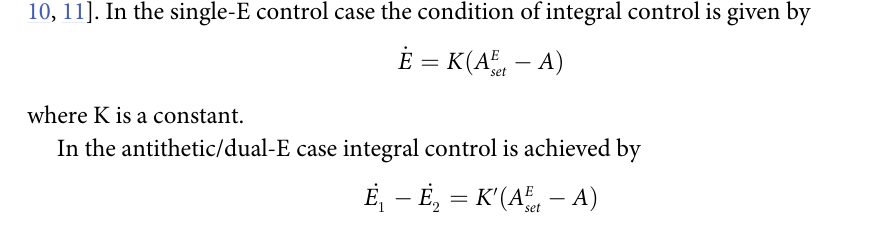
Fig 1. The concept of integral control. In single-E controllers the variable E is proportional to the integrated error � , used to correct for perturbations in A. In dual-E (antithetic) controllers the difference between variables E 1 and E 2 is proportional to the integrated error (see S1 Text). In both cases integral control will move A precisely to its set-point A set when A is perturbed by step-wise perturbations